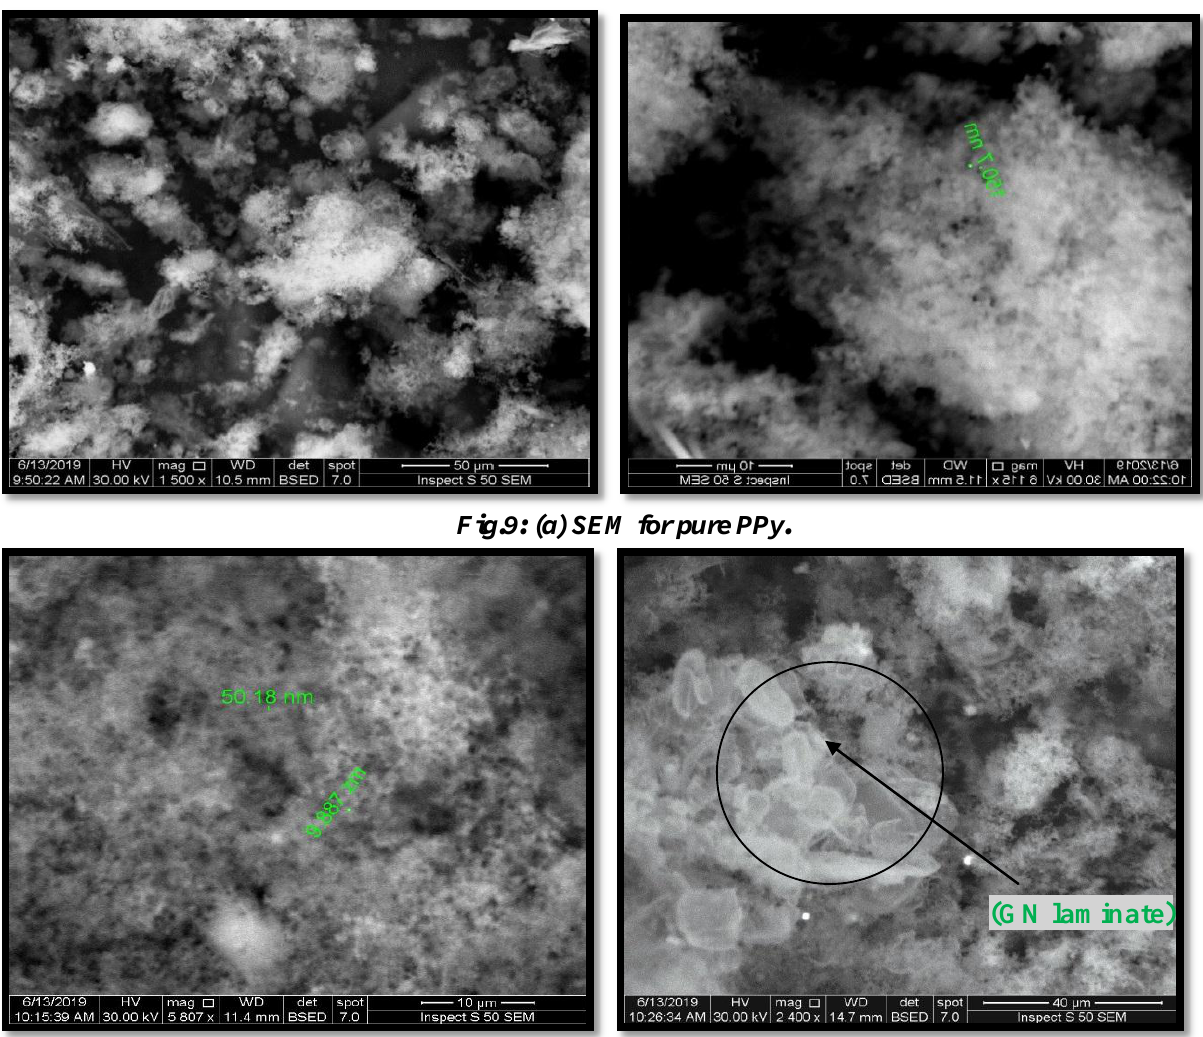
Fig.9: (b) SEM for PPy with